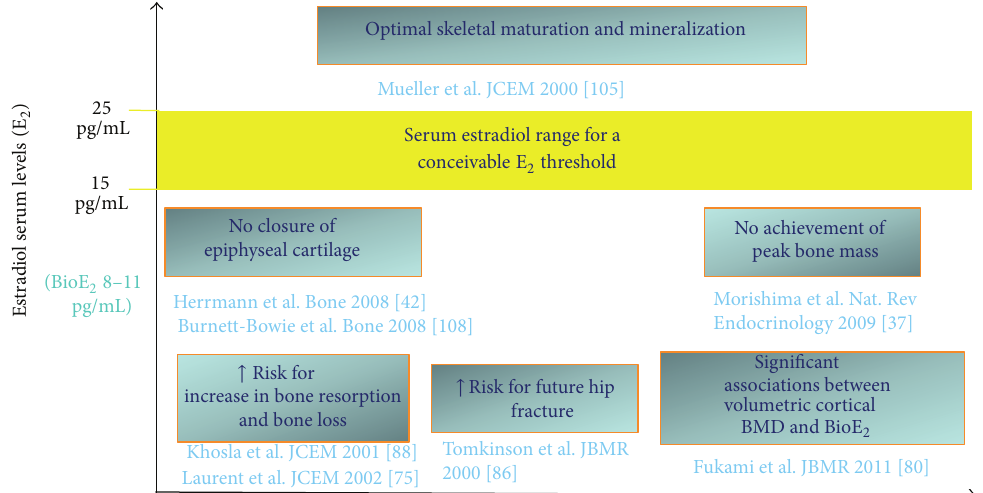
Figure 2: Proposed range for a critical serum estradiol threshold above which both skeletal maturation and mineralization can proceed in an optimal way. E 2 : estradiol; BioE 2 : Bioavailable